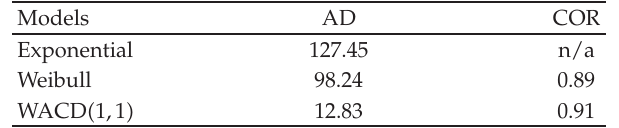
Table 4: Goodness-of-fit test for di ff erent congestion duration models.